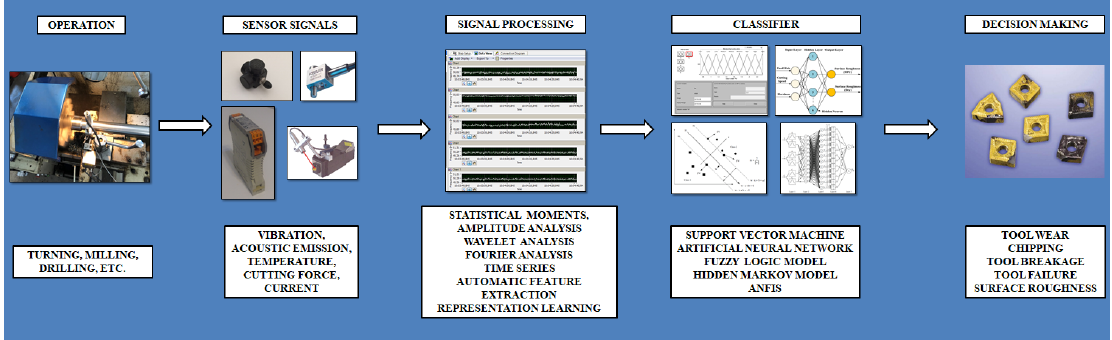
Figure 11. The whole procedure of monitoring of tool condition via